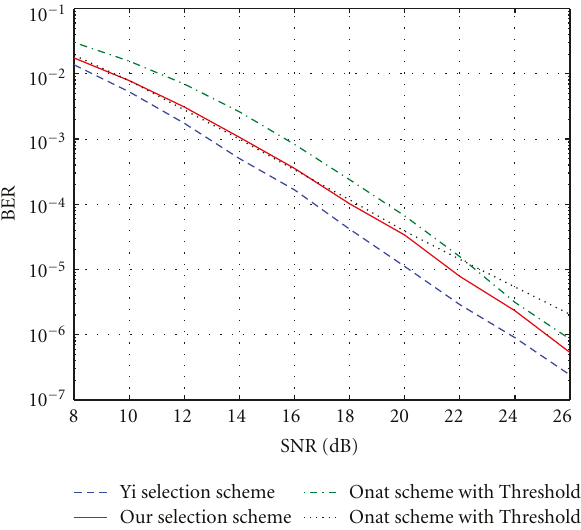
Figure 6: BER performance comparison between our selection scheme and two other selection schemes when R =